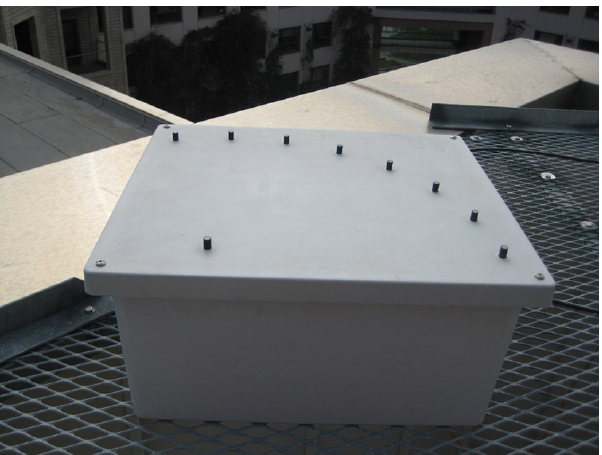
Figure 2. cloud shadow speed sensor (CSS). The entire system is contained inside a weather-proof enclosure. On the top of the enclo- sure is an array of nine phototransistors used to measure the varia- tion in solar radiation as clouds passed